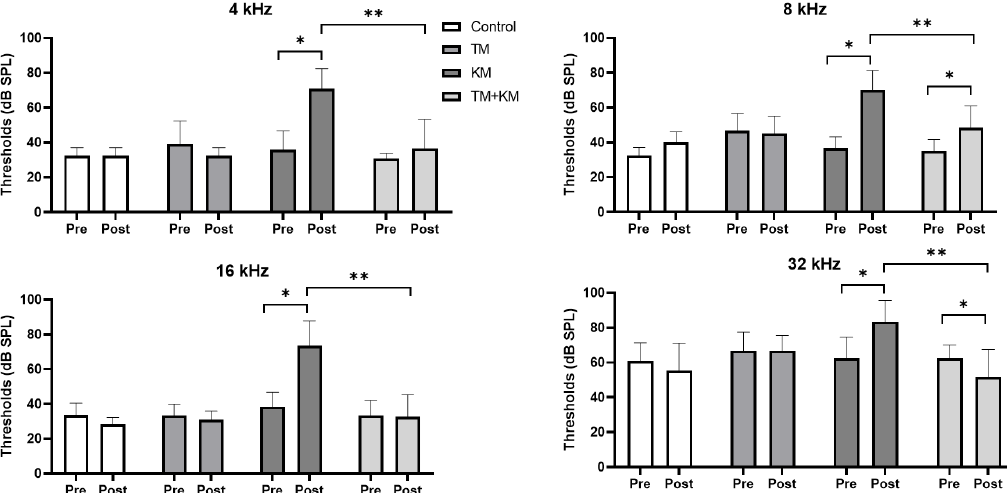
Figure 1. Auditory brainstem response (ABR) thresholds at 4, 8, 16, and 32 kHz pre- and post-drug administrations. TM: flutamide, KM: kanamycin, * p < 0.05 paired t -test between pre- and post-treatment ABR thresholds, ** p < 0.05 in unpaired t -test between KM and KM + TM groups.